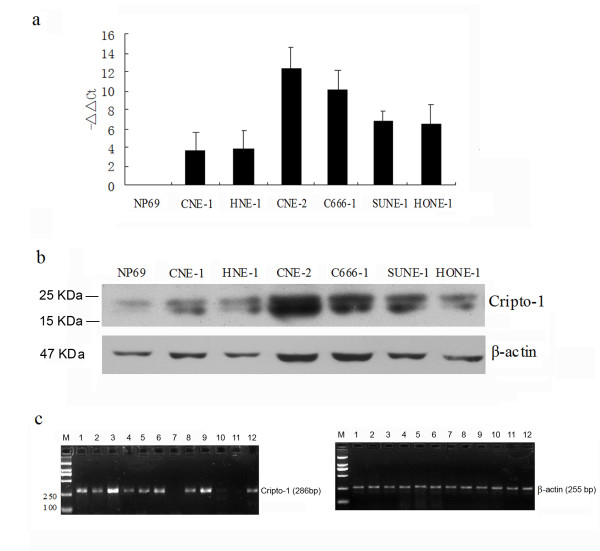
Summary of Cripto-1 expressions in NPC cell lines and tissues. Expressions of Cripto-1 mRNA and protein in immortalized nasopharyngeal epithelial cell line (NP69), and NPC cell lines (SUNE-1, C666-1, HNE-1, HONE-1, CNE-1 and CNE-2) were examined by real-time RT-PCR (a) and Western blotting (b). Compared to NP69, Cripto-1 expressions were up-regulated in all NPC cell lines (p < 0.05, respectively). (c) 1.5% agarose electrophoresis of Cripto-1 RT-PCR products in NPC tissues. Representative results from 12 NPC cases are shown. β-actin was used as an internal quantitative control. M: Marker; 1~6, 8, 9, 12: positive expression of Cripto-1 mRNA; 7, 10, 11: negative expression of Cripto-1 mRNA.